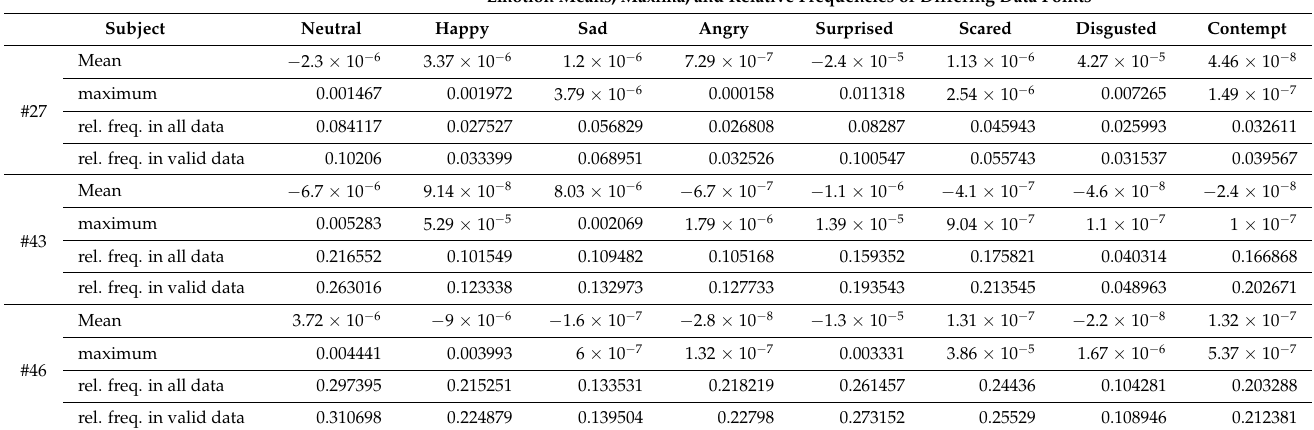
Table A6. Residual differences between test 2 and test 3 intensity data for the 7 cases which did not “stabilize” for the test 2 –test 3 comparison. All maxima are absolute values. Frequencies of differing data points are shown relative to (i) the number of all data points: “rel. freq. in all data”, and to (ii) the number of “valid” data points with numerical intensity values (thus excluding data points with FIT_FAILED or FIND_FAILED error signals): “rel. freq. in valid data”. Emotion Means, Maxima, and Relative Frequencies of Differing Data Points